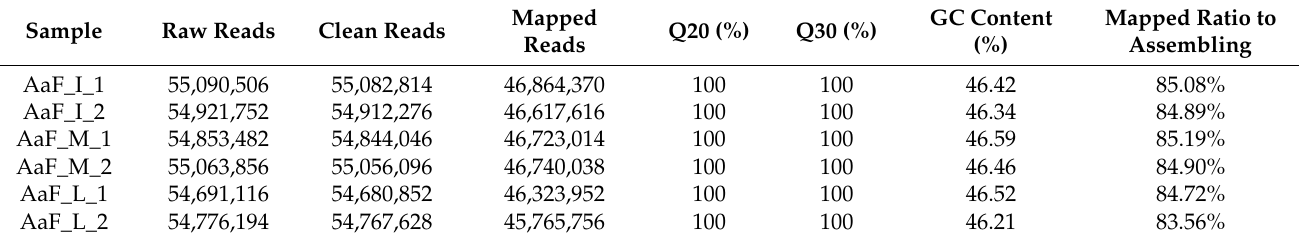
Table 1. Summary of sequence assembly after sequencing.